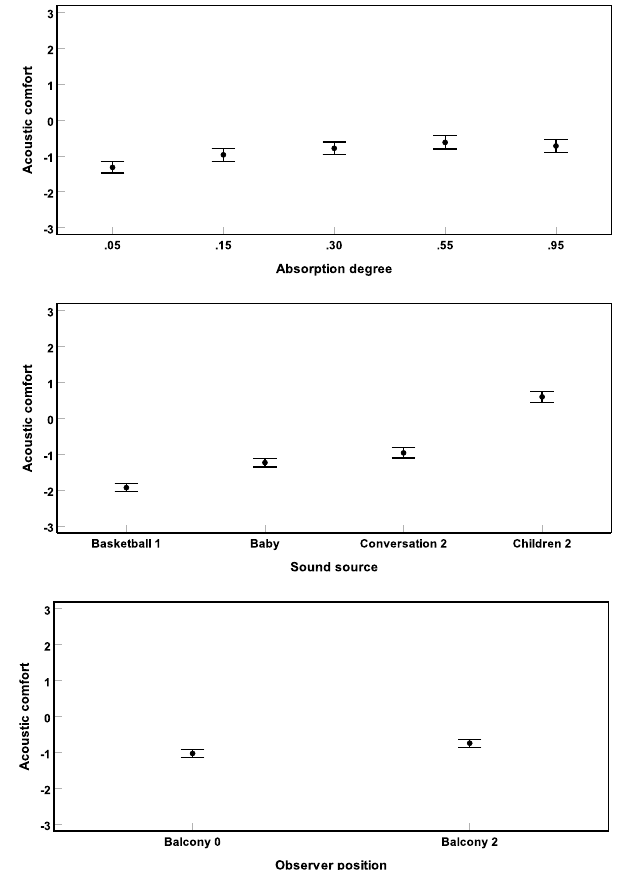
Figure 7. Results of Experiment 2: Mean acoustic comfort ratings across subjects and their 95% confidence intervals are shown for different absorption degrees α w ( above ), sound sources ( middle ), and observer positions ( below